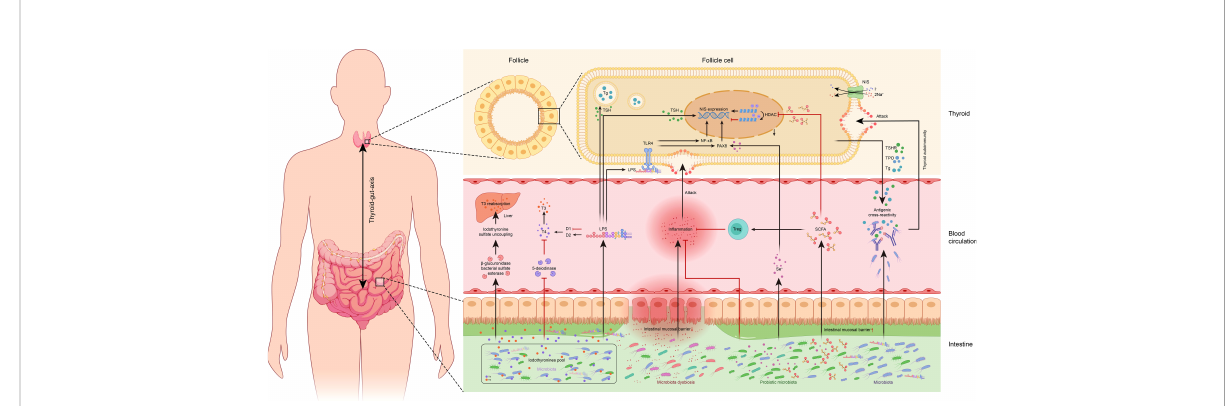
FIGURE 1 Overview of potential associations between the gut microbiota and thyroid. TSH, thyroid-stimulating hormone; Tg, thyroglobulin; TSHR, thyroid-stimulating hormone receptor; TPO, thyroid peroxidase; NIS, sodium/iodide symporter; HDAC, histone deacetylase; TLR-4, toll-like receptor 4; LPS, lipopolysaccharide; NF- k B, nuclear factor kappa-B; PAX8, paired box 8; T3, triiodothyronine; T4, thyroxine; D1, type I iodothyronine deiodinase; D2, type II iodothyronine deiodinase; Treg: regulatory T cells; Se+, selenium; SCFA, short-chain fatty